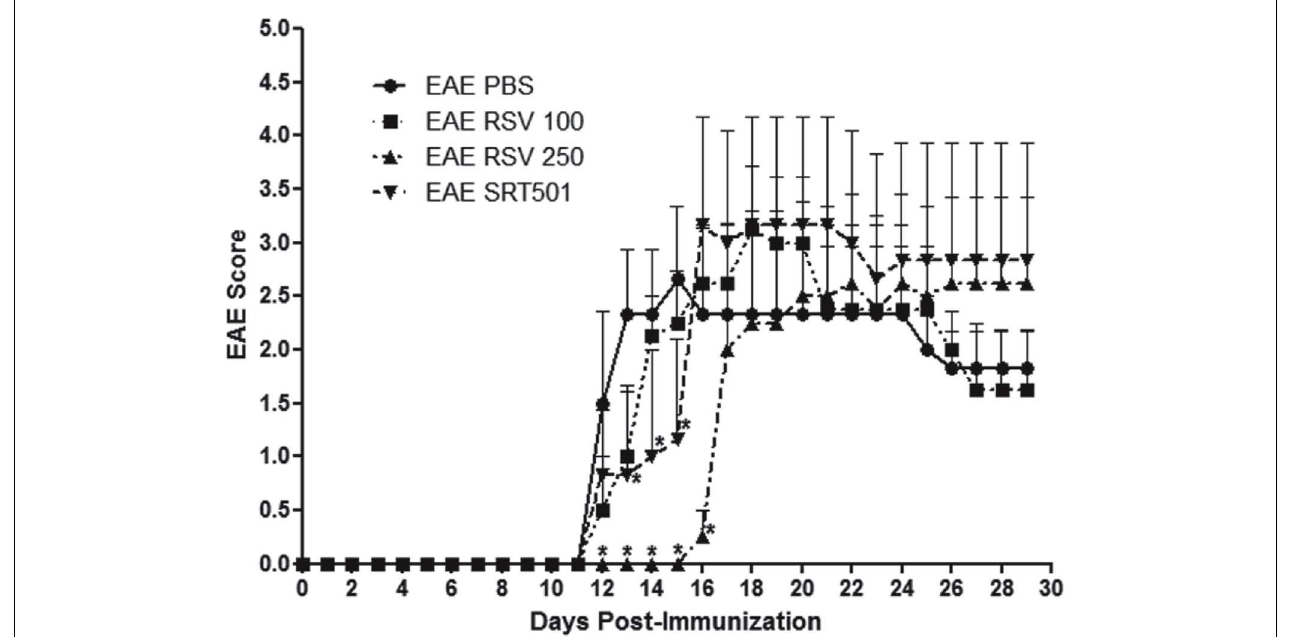
FIGURE 1 | Resveratrol delays onset of EAE. Eight week old female C57/Bl6 mice were immunized with MOG on day 0, and mice treated